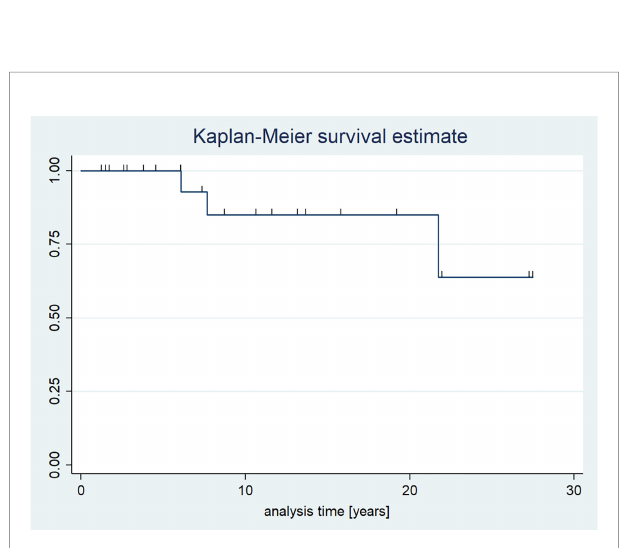
FIGURE 4 | Causes of PST in male (age at the time of the diagnosis). *LCH, Langerhans cell